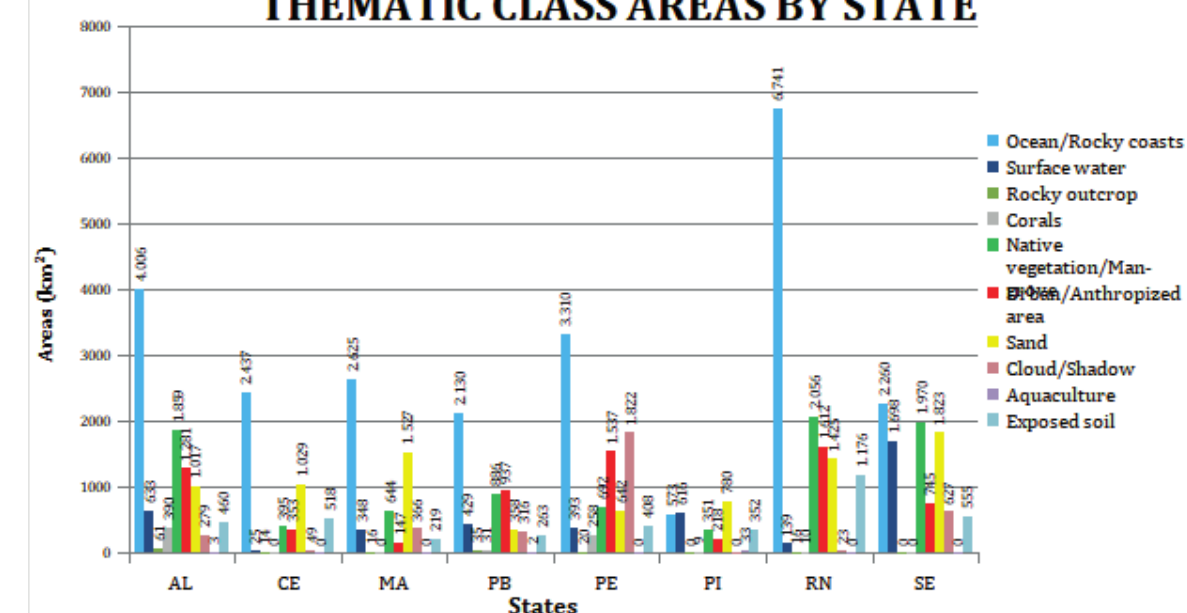
Figure 9. Totals of thematic areas by state on the beaches affected by the disaster. Source: Authors’ elaboration based on digital image processing from the Sentinel-2B satellite